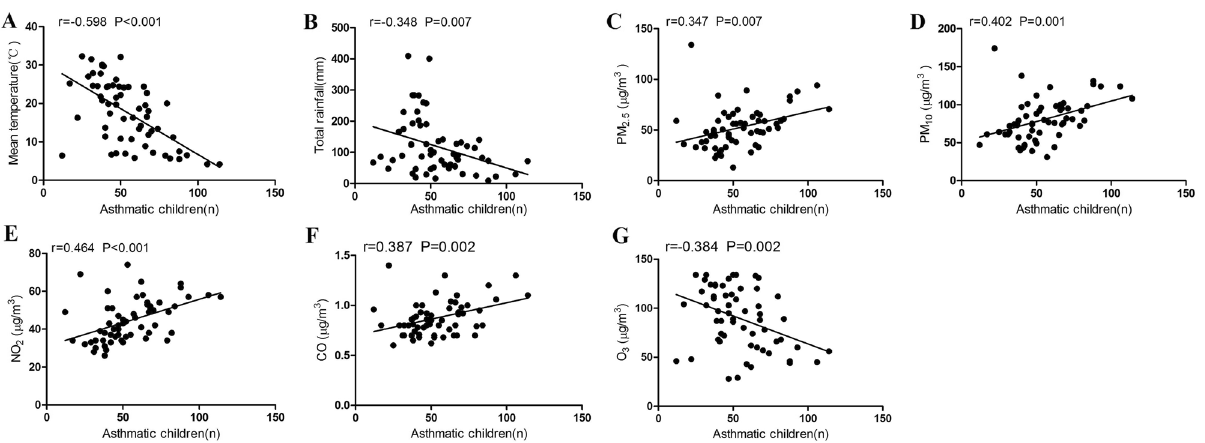
Figure 3. Correlation between meteorological, environmental factors and wheezing diseases in children (Pearson correlation analysis) ( A ) mean temperature; ( B ) total rainfall; ( C ) PM 2.5 ; ( D ) PM 10 ; ( E ) NO 2 ; ( F ) CO; ( G ) O 3 . Figures were generated using GraphPad Prism version 5 (https:// www. graph pad. com/ scien tific- softw are/ prism/) and Adobe Illustrator version CC 2018 (https:// www. adobe. com/ cn/ produ cts/ illus trator.